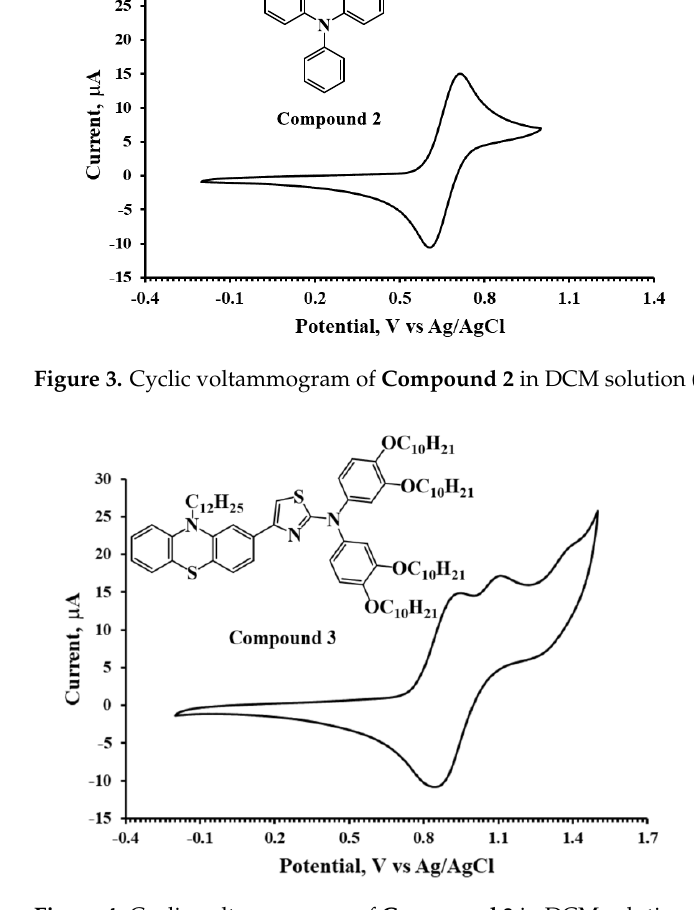
Figure 4. Cyclic voltammogram of Compound 3 in DCM solution (10 − 3 M).